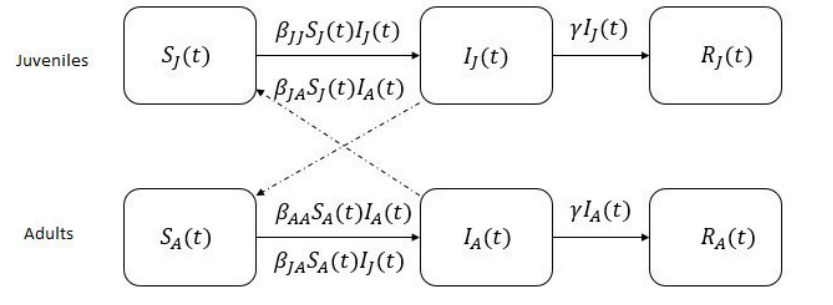
Fig. 5 An example of an SIR model structured by age groups. The population is partitioned into two age groups, juvenile, and adult, and in each of these age groups the subpopulation is again partitioned into susceptible ( S ), infected ( I ) and recovered ( R ). Each of these age groups has a different level of interaction within their own age group and with people from the other